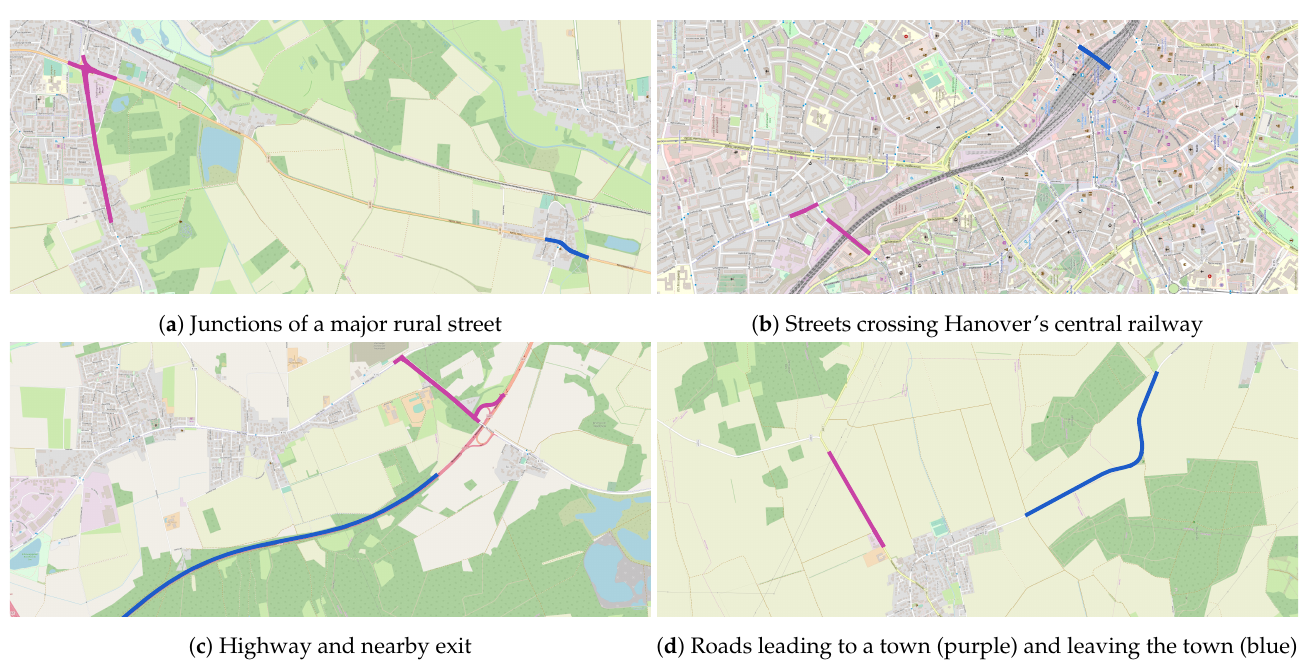
Figure 4. Examples of the identified dependencies between subgraphs in Hanover. Dependent subgraphs are marked in blue and purple. Map images: c (cid:13) OpenStreetMap contributors, ODbL. Figure 5 provides examples of identified dependent subgraph pairs in